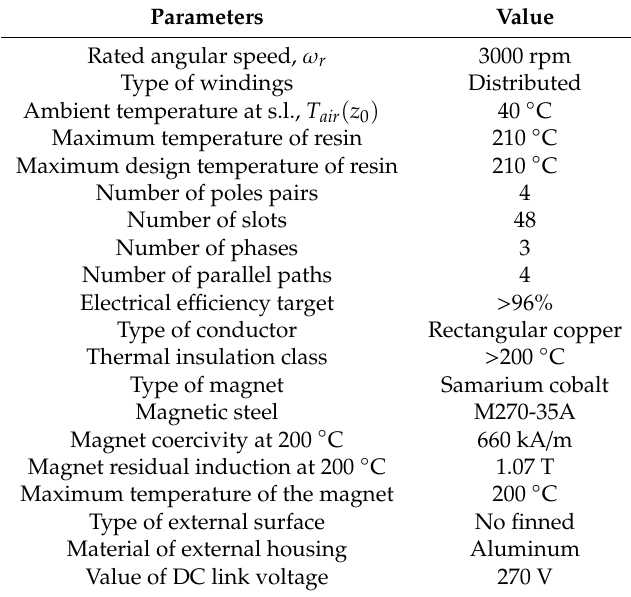
Table 2. Desired motor characteristics Problem